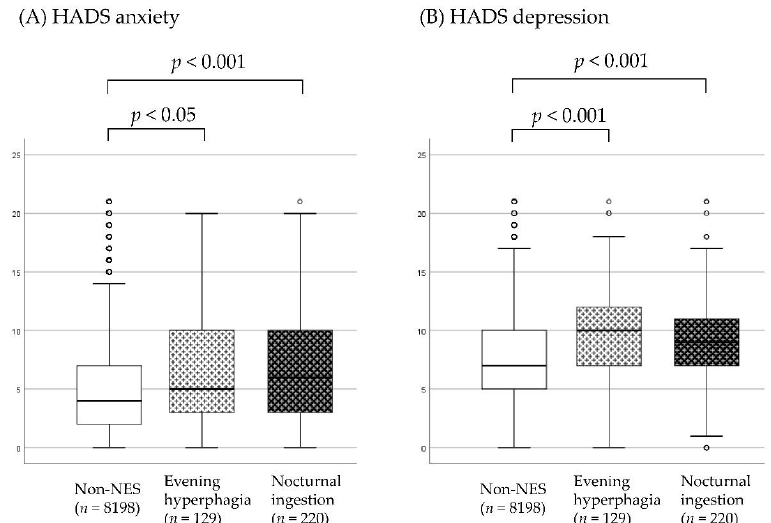
Figure 1. Box-and-whisker plot showing the Hospital Anxiety and Depression Scale (HADS) scores of the non-night eating syndrome (non-NES), evening hyperphagia, and nocturnal ingestion groups. HADs anxiety and depression scores are shown in ( A , B ), respectively. Comparisons were made using the Mann-Whitney U test.